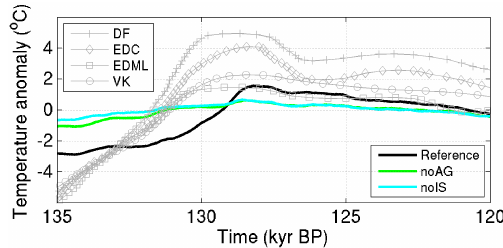
Figure 6. Comparison of modelled East Antarctic temperature evo- lution with reconstructed temperature changes at deep ice core sites. Modelled temperature anomalies are averaged over a region 72– 90 ◦ S and 0–150 ◦ E. Ice core temperature reconstructions for the sites EPICA Dronning Maud Land (EDML; 75 ◦ 00 (cid:48) S, 00 ◦ 04 (cid:48) E), Dome Fuji (DF; 77 ◦ 19 (cid:48) S, 39 ◦ 40 (cid:48) E), Vostok (VK; 78 ◦ 28 (cid:48) S, 106 ◦ 48 (cid:48) E), and EPICA Dome C (EDC; 75 ◦ 06 (cid:48) S, 123 ◦ 21 (cid:48) E) are from Masson-Delmotte et al.